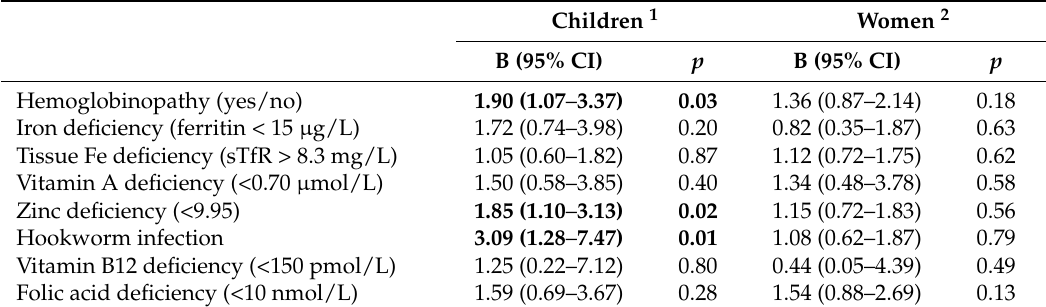
Table 7. Relative risks for anemia in children ( N = 305) and women ( N = 363) in a full model 1